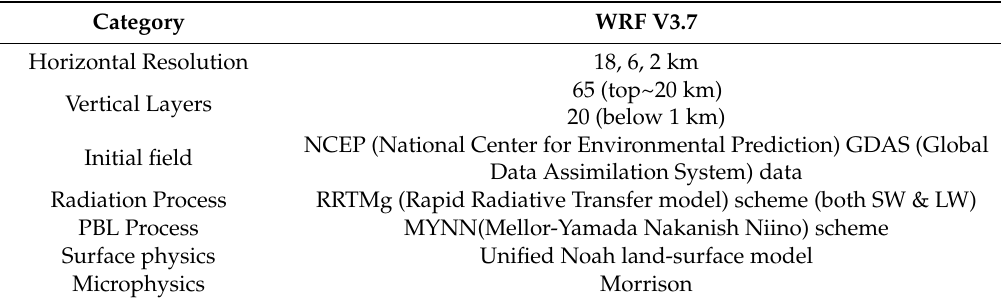
Figure 2. Domain setting of the 3D Weather Research and Forecasting (WRF) model. Table 2. Summary of the 3D model